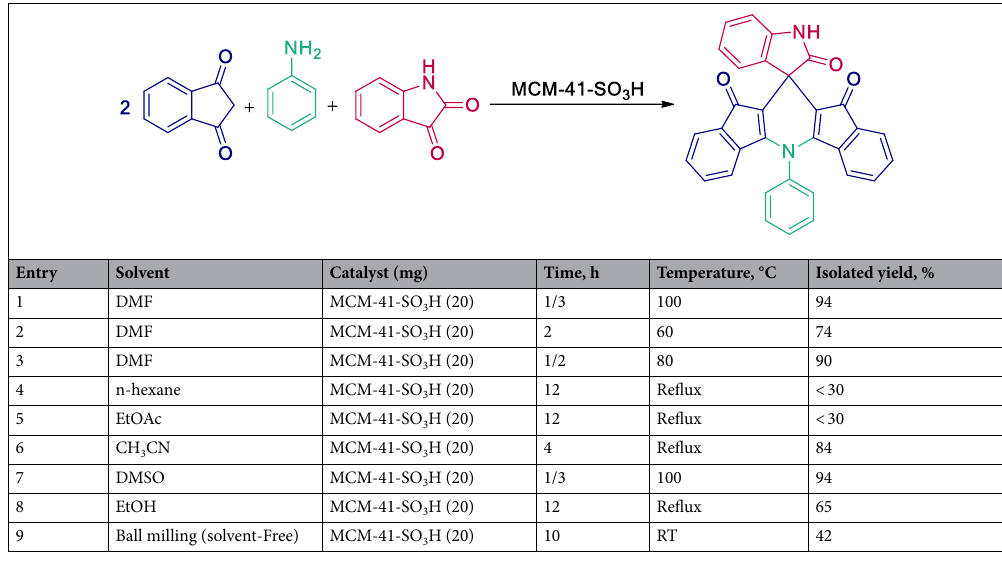
Table 2. The evaluation of different solvents and reaction temperatures in the model reaction. Reaction conditions: isatin (1 mmol), 1,3-indanedione (2 mmol), aniline (1 mmol) and solvent (1 mL).